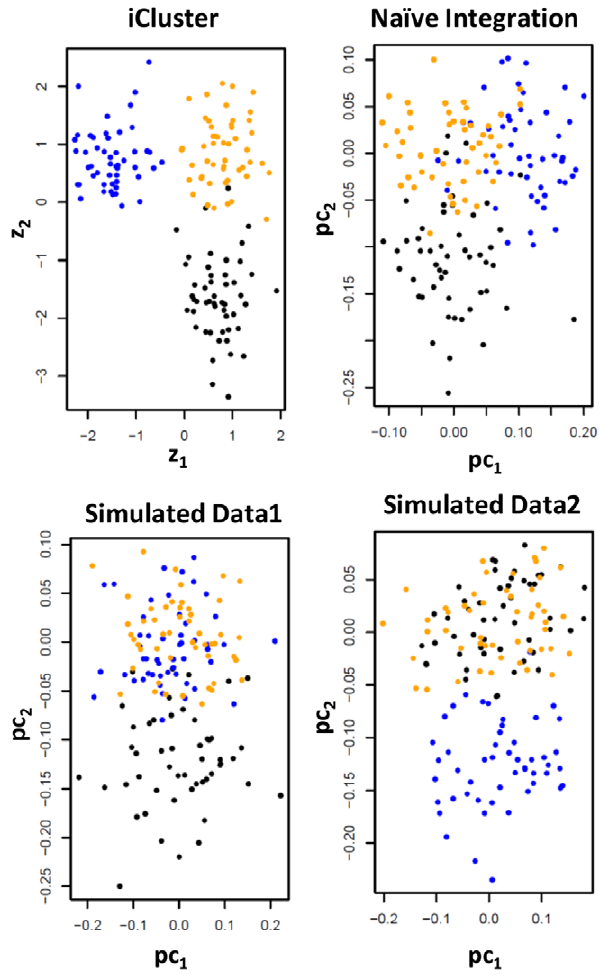
Figure 2. Comparing iCluster to a naive integration via PCA using simulated data. Two-dimensional plots of the sample points in the latent subspace by different methods. A set of 150 subjects are simulated belonging to three clusters (indicated by black, blue, and orange dots). Each subject has a pair of synthetic molecular profiles representing two data types each consisting of 1,000 features. A common set of 5 correlated features in both data type 1 and 2 defines the black subtype. Another set of 5 features specific to data type 2 defines the blue subtype. The remaining features are noise.